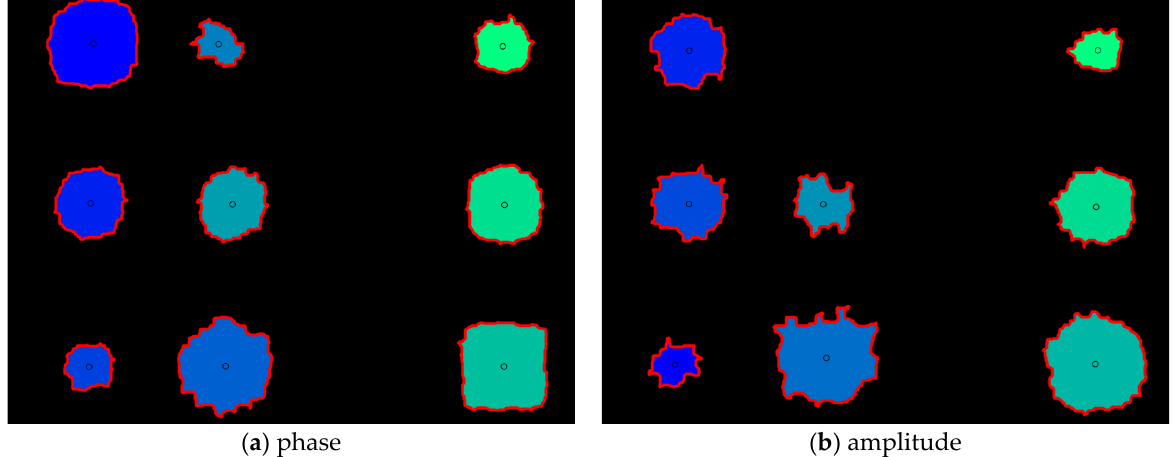
Figure 14. Images of phase and amplitude with automatic defect detection using boundary tracking algorithm.